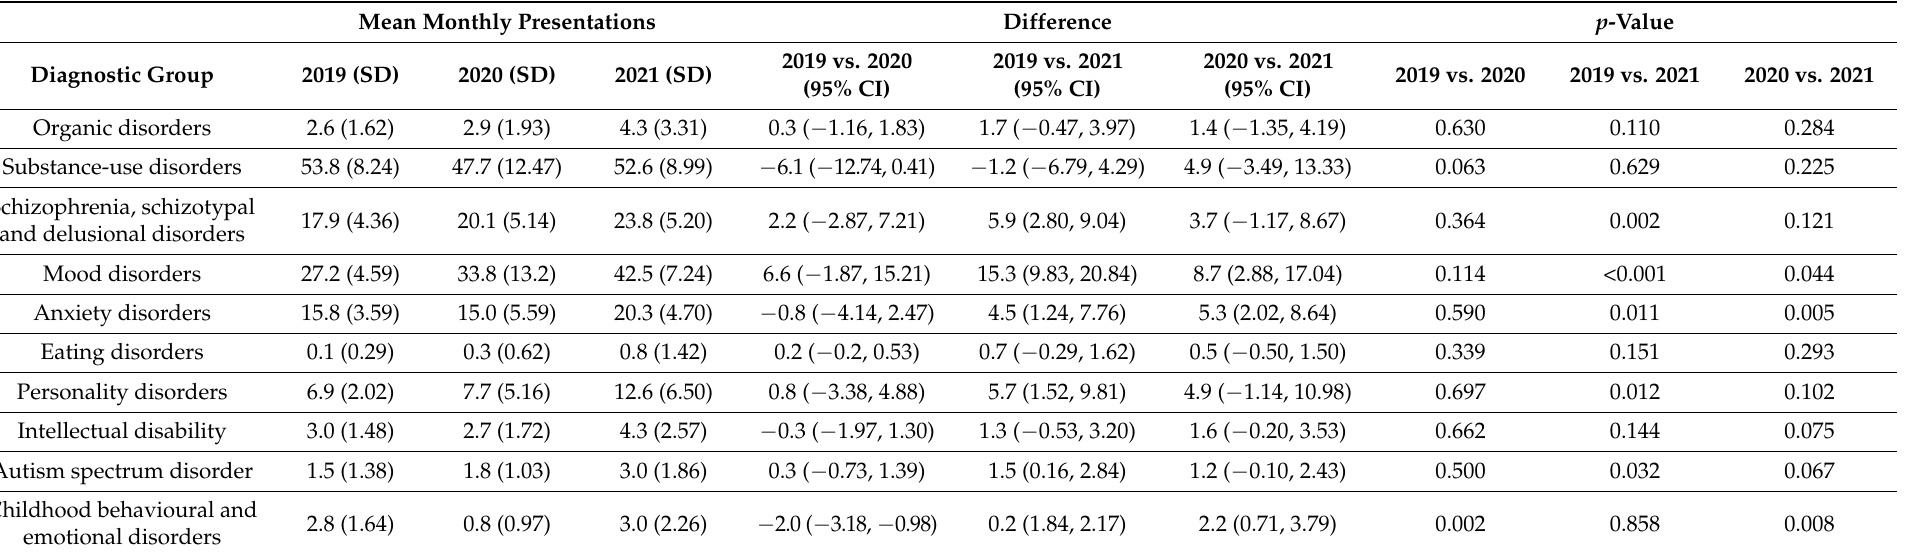
Table 1. Psychiatric Diagnosis: Comparison of mean monthly presentations for the first and second years of the pandemic vs. the pre-pandemic reference year.